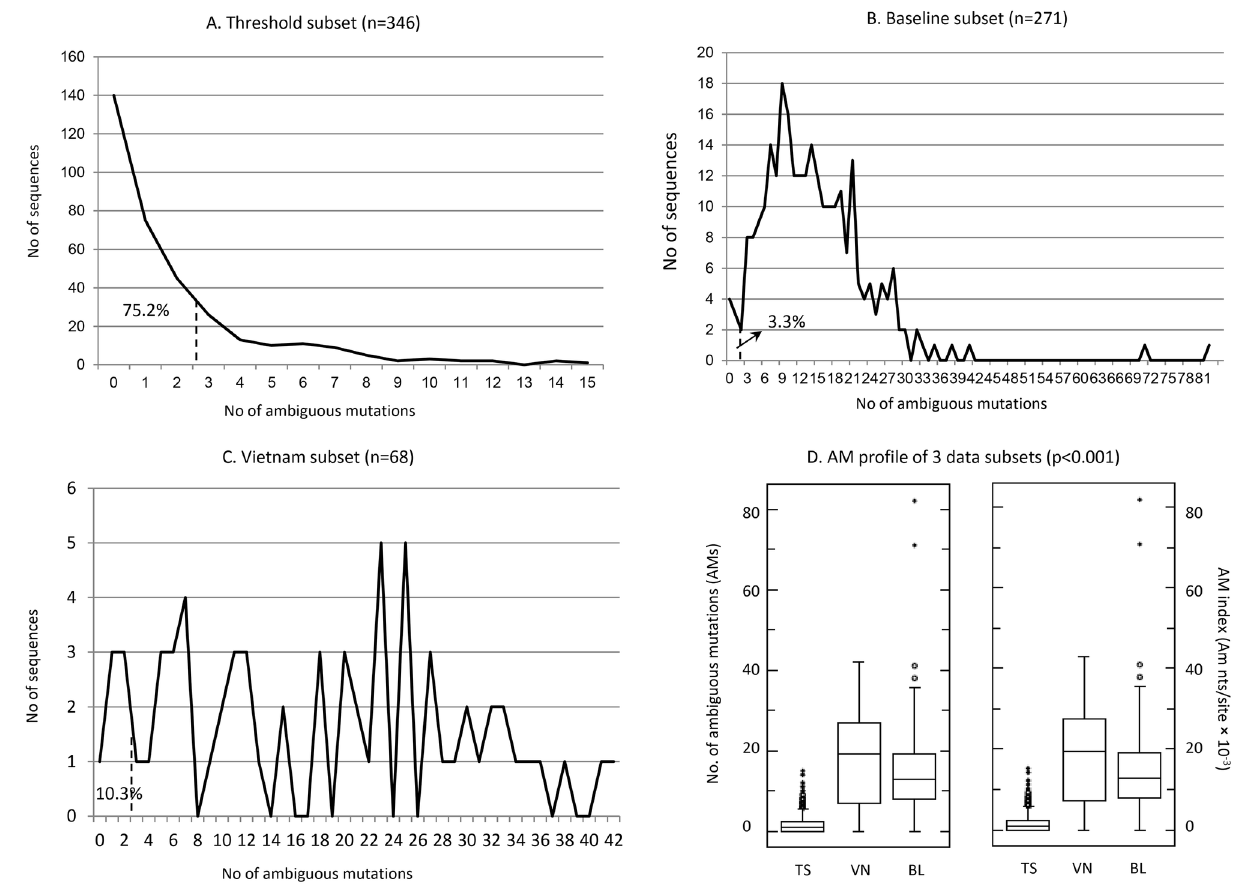
Figure 2. Distribution of ambiguous mutations and data statistical description of three data subsets. Sequence frequency distribution with number of ambiguous mutations (AMs) was plotted by subset: (A). Threshold (n=346), (B). Baseline (n=271), and (C). Vietnam (VN) (n=68); and the statistical description of the 3 data subsets was plot (D) by number and index of ambiguous mutations using the same method as described in Figure 1. The percentage in A-C indicated recent infections in a dataset classified by having ≤2 AMs per sequence (indicated by dash